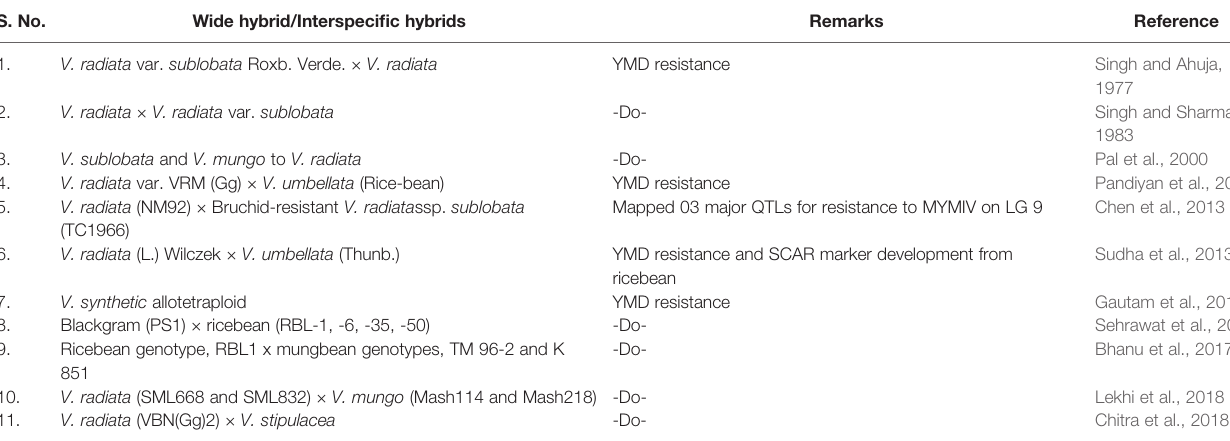
TABLE 3 | Wide-hybridization for the creation of YMD